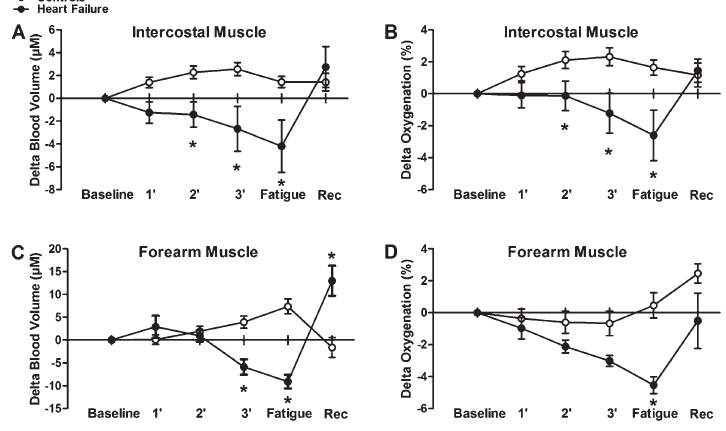
Figure 2. Changes in tissue blood volume ( A and C ) and oxygenation ( B and D ) at intercostal and forearm muscles during respiratory muscle fa- tigue in patients with heart failure and in healthy controls. Data are reported as means±SD. Fatigue: average of the last 3 s before fatigue occurred; REC: recovery. *P , 0.05 fatigue vs baseline (two-way ANOVA followed by the Bonferroni post hoc